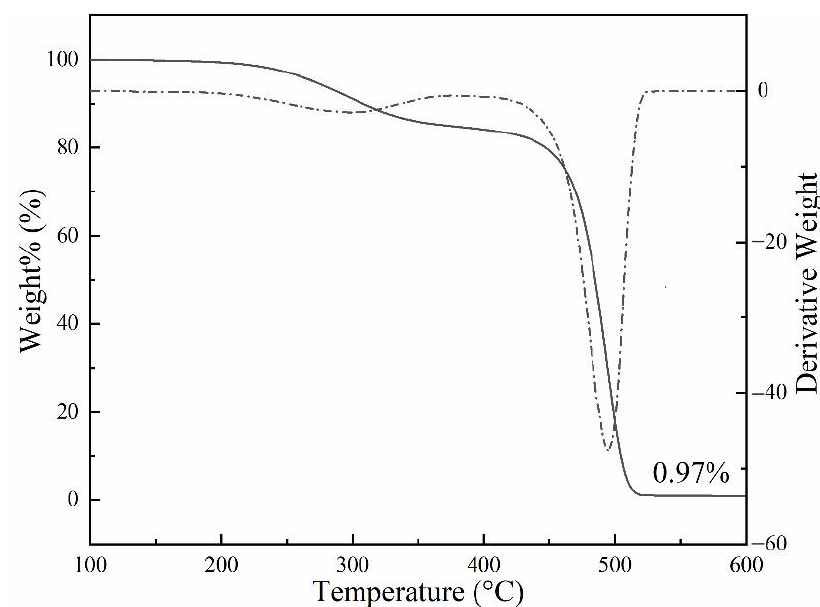
Figure 3. TG-DTG curves of the phase change thermoregulated fiber.